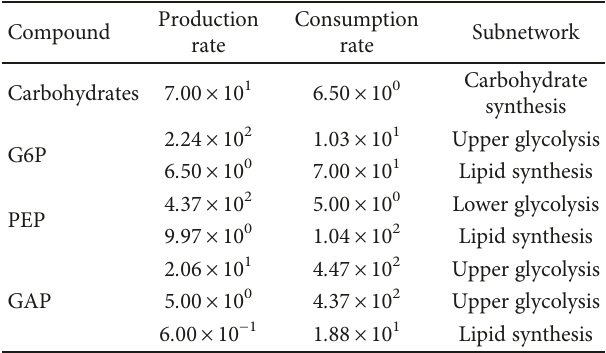
Table 6: Rates are in h − 1 · mM · B − 1 . Typical concentrations in Table 5 were used to estimate the consumption rates for GAP and PEP in the lipid synthesis